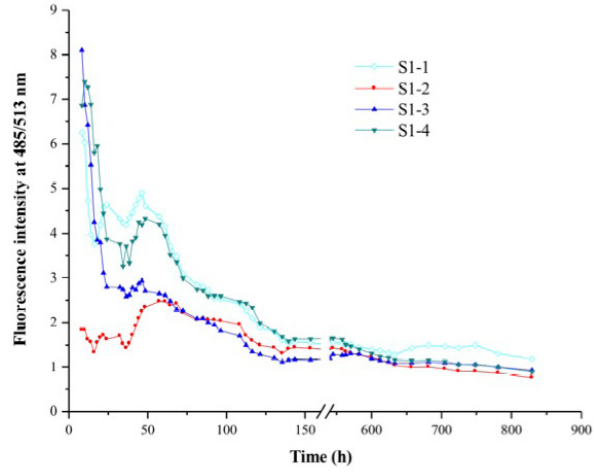
Figure 4: Fluorescence intensity in observation wells S1-1 to S1-4.